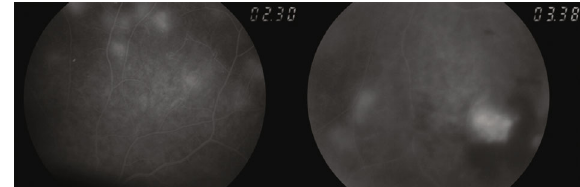
Figure 4: Fluorescein angiography showing signi fi cant occlusive vasculitis associated with peripheral ischemia, hemorrhages, and neovascularization in both eyes in patient